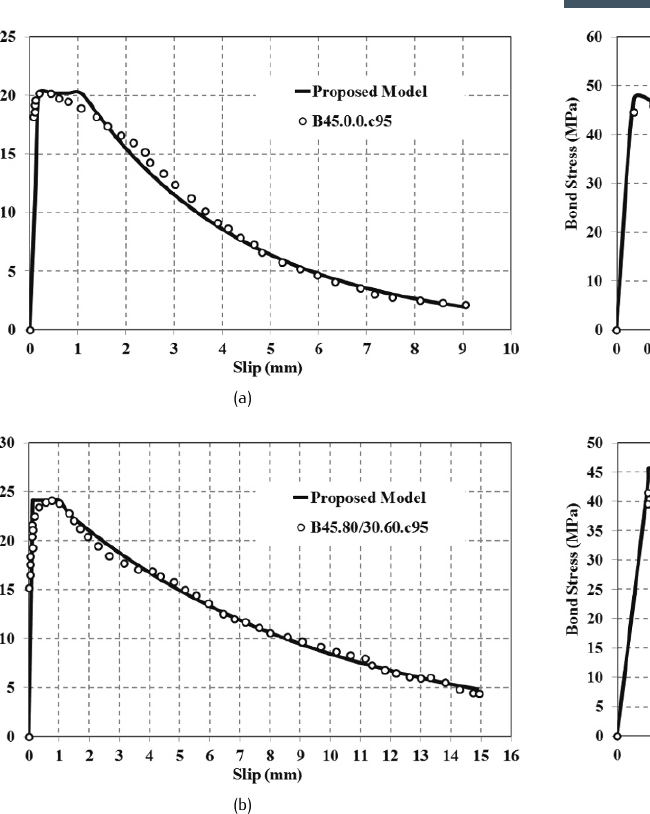
Figure 17. Comparison of the experimentally obtained load-slip curves (Schumacher [30]) versus the predicted curves by using the proposed model for (a) f 0 c = 105 , without fiber and concrete cover = 35 and (b) f 0 c = 105 , with fiber “aspect ratio: 80/30” and “fiber content: 60 (kg/m 3 )”, and concrete cover =